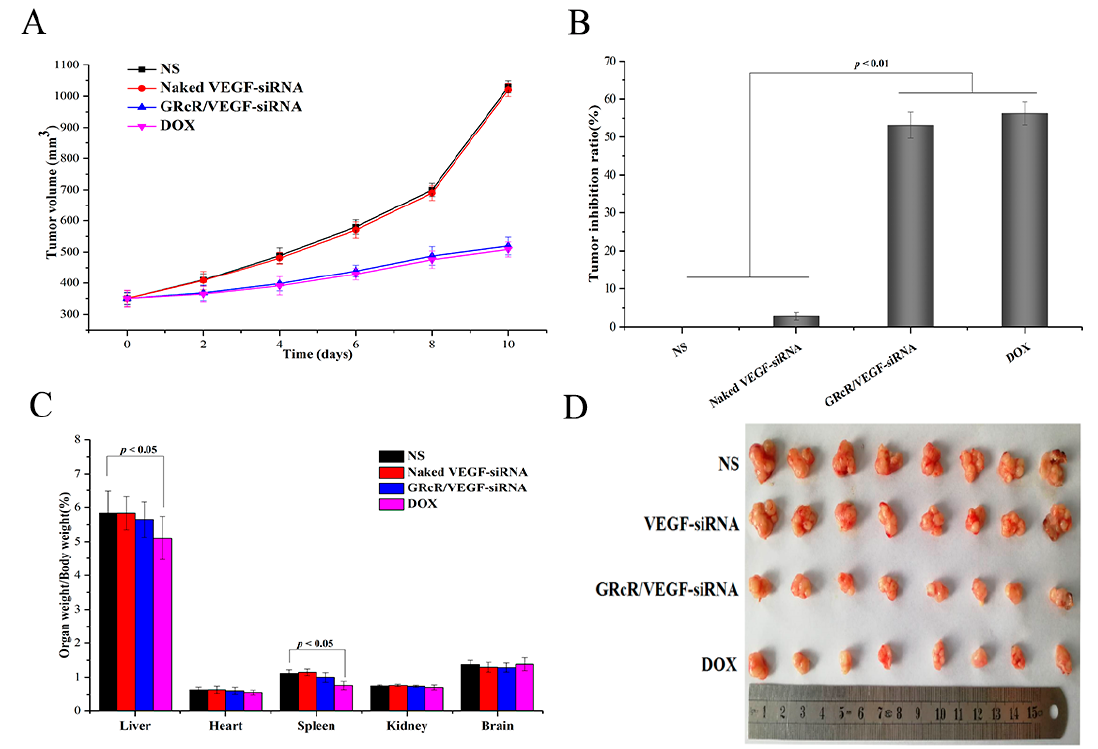
Figure 15. In vivo tumor growth assay. ( A ) Tumor volume. ( B ) Tumor inhibition rate of test groups. ( C ) The ratios of organ/bodyweight. ( D ) Image of tumors. The data is presented as the mean ± SD, n = 3.